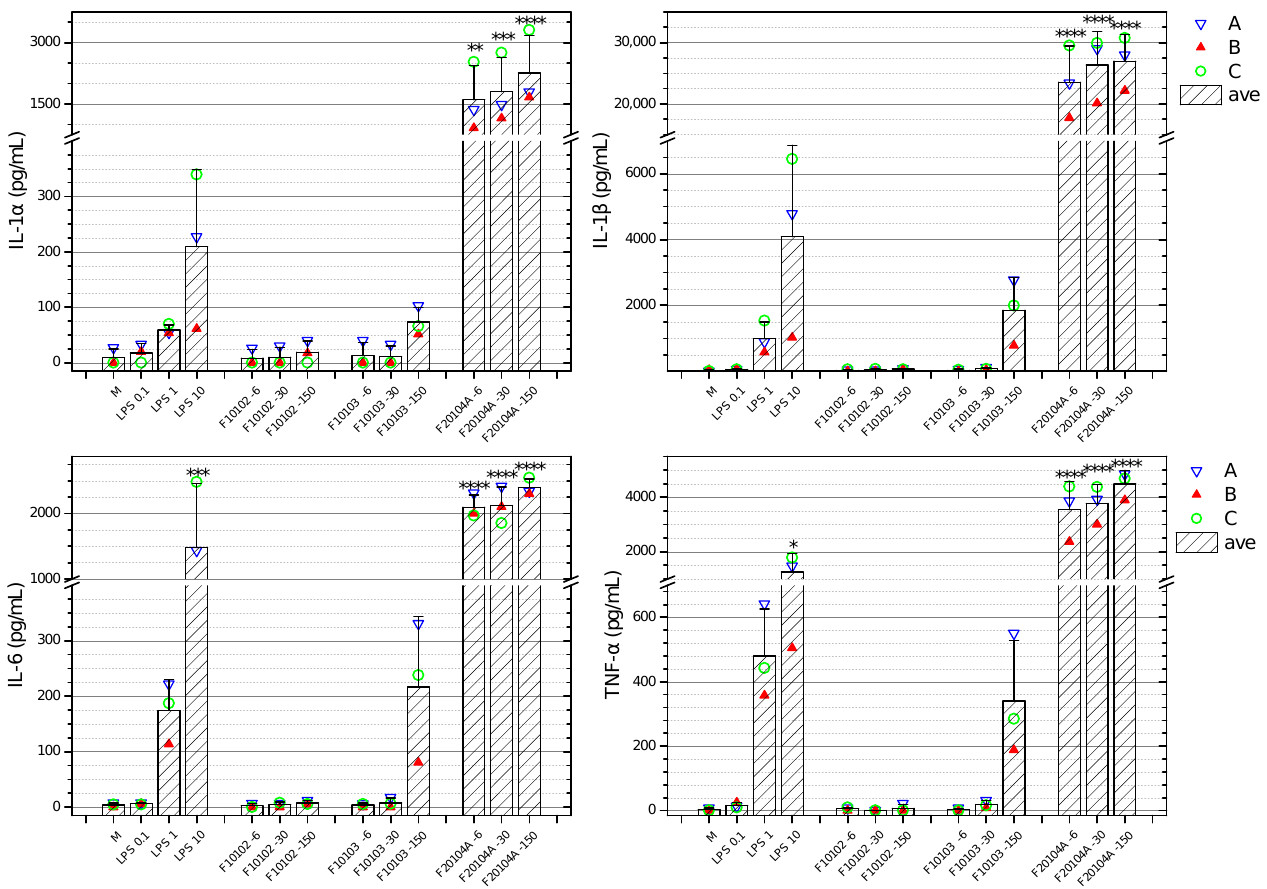
Figure 8. Whole blood from three healthy donors (represented in blue, red, green) was incubated for 24 h with selected liposomes at three concentrations (6, 30, 150 µ g/mL). The production of IL-1 α , IL-1 β , IL-6, and TNF- α data is here reported. M represents the negative control (whole blood exposed to medium only), whereas LPS was used as a positive control at the concentrations of 0.1, 1 and 10 ng/mL. Data are also shown as mean (shaded bars) ± SD. * p < 0.05, ** p < 0.01, *** p < 0.001, **** p <